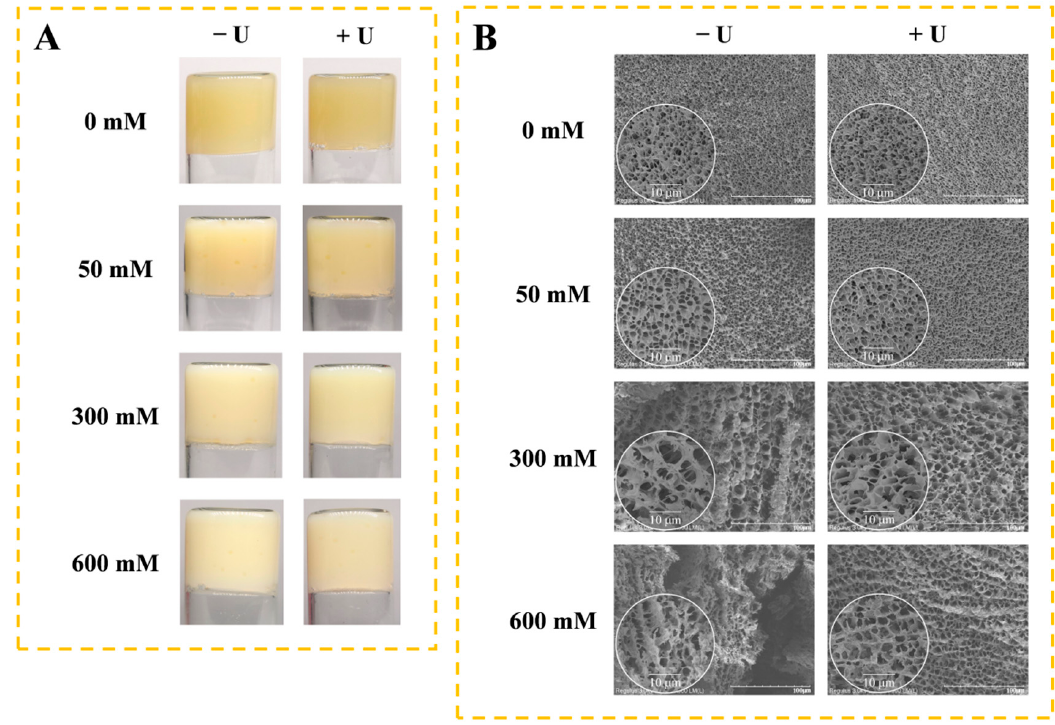
Figure 6 . Macrostructure ( A ) and microstructure ( B ) of soy protein isolate gels as influenced by different concentrations of NaCl with ultrasound treatment. − U: SPI without ultrasound treatment; + U: SPI with 30 min of ultrasound treatment.